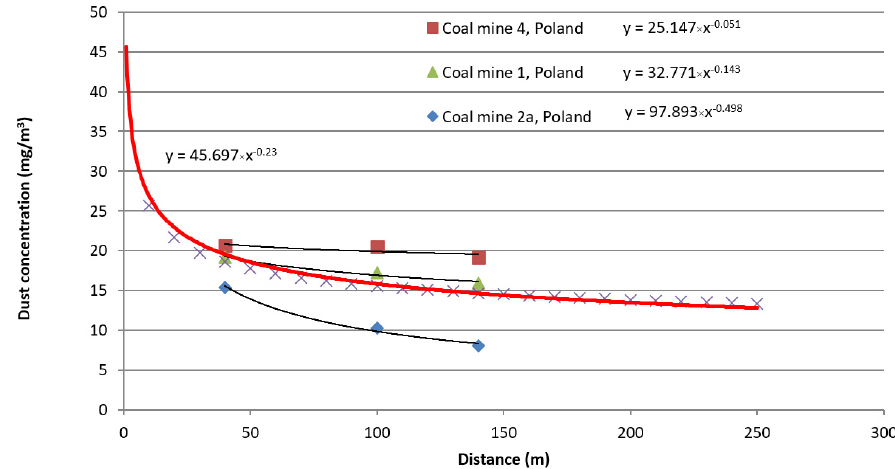
Figure 18. Equivalent characteristics of PM10dust concentration (measured by Pł-2 dust meter), depending on the distance from the dust source, determined on the basis of dust measurements in two coalfaces.